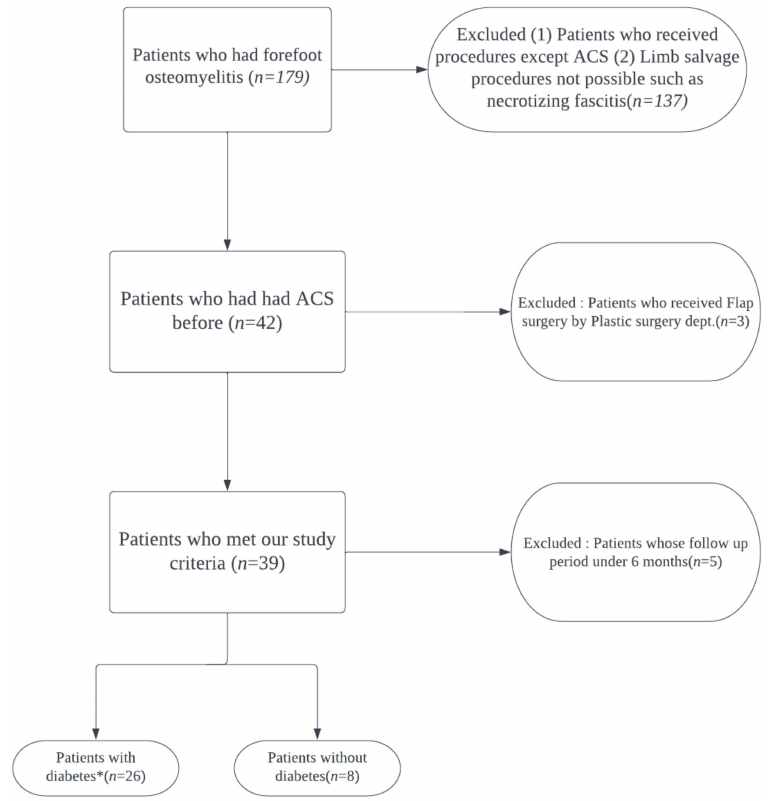
Figure 1. Patient selection flow chart. (* One patient belonging to the diabetic group occurred on the left and right for different periods, respectively, and was considered as each